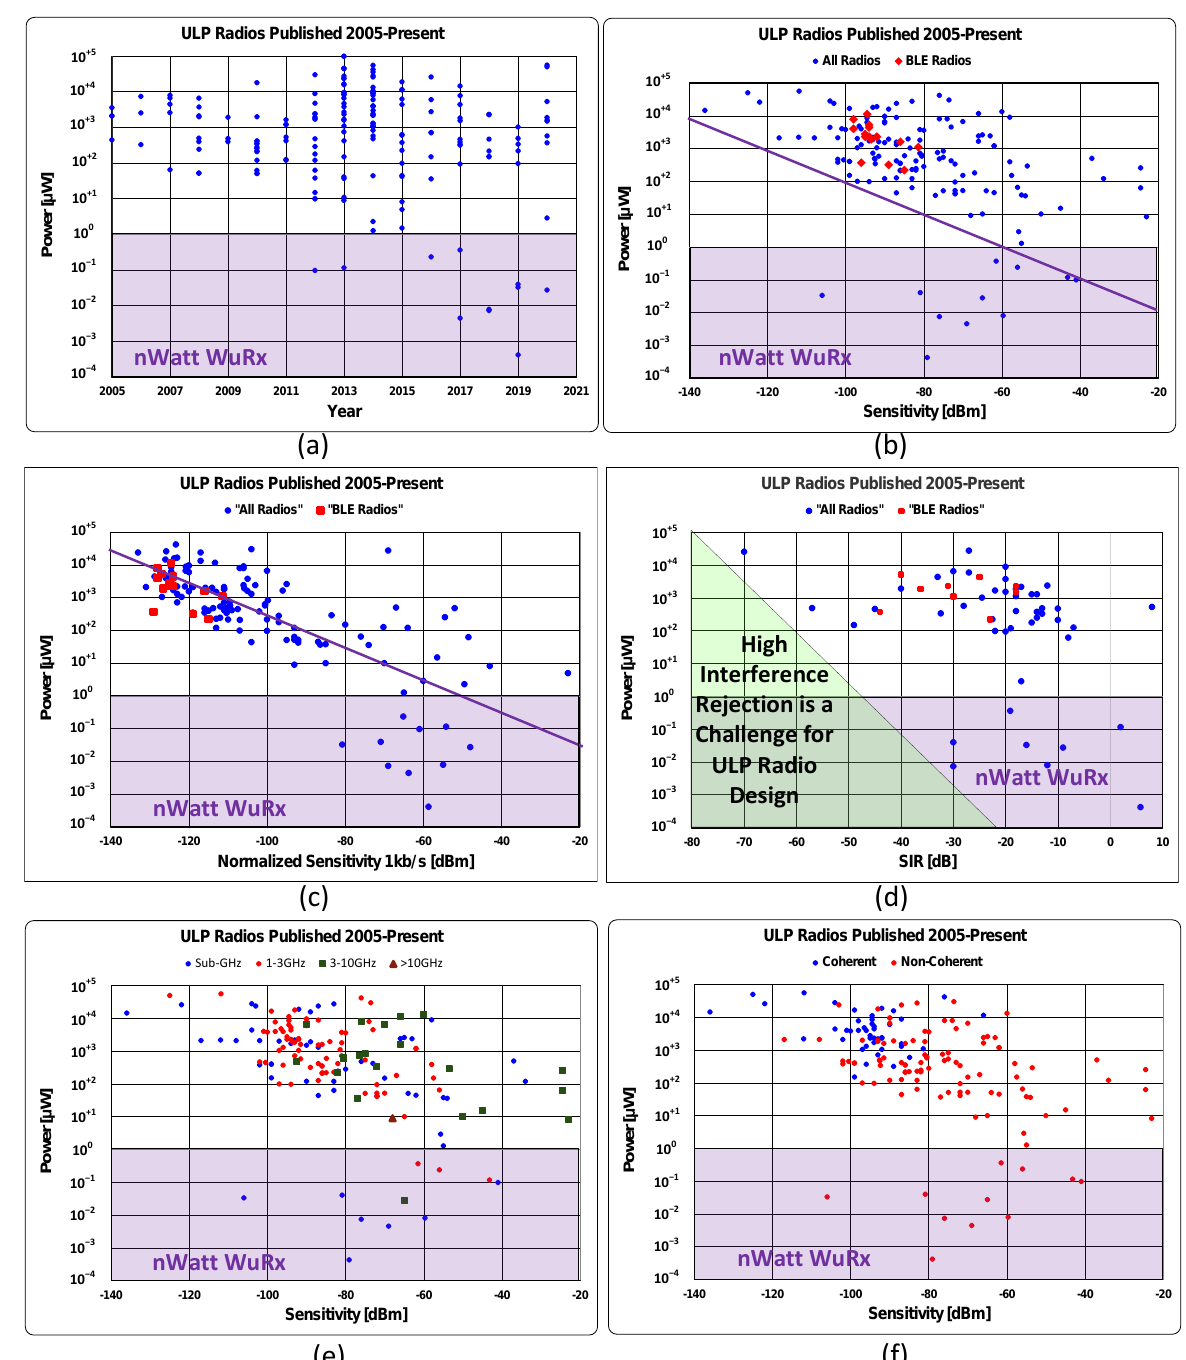
Figure 6. ULP (ultra-low power) receivers’ survey showing different design trade-offs. ( a ) Power trend of published receivers over years; ( b ) power consumption versus sensitivity; ( c ) power consumption versus normalized sensitivity; ( d ) power versus signal-to-interference ratio (SIR); ( e ) power versus sensitivity at different frequency ranges; and ( f ) power versus sensitivity for different modulation schemes.